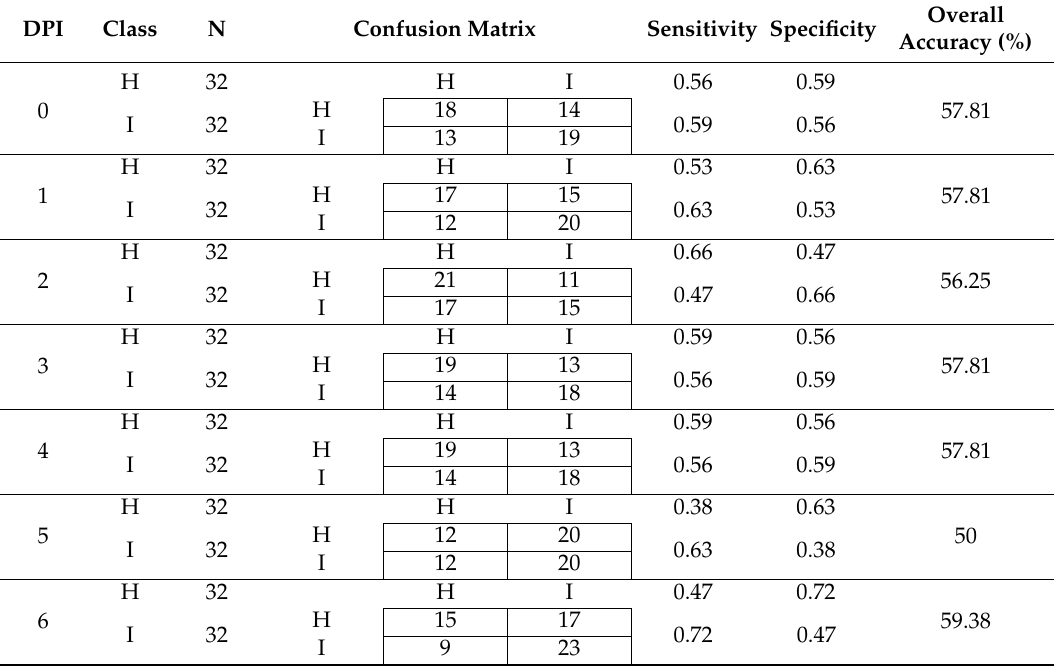
Table 4. Confusion matrix and related statistics when a linear Support Vector Machine (SVM) classifier is applied to the red-well point (RWP) wavelength to classify 32 healthy and 32 infected spectral observations acquired at canopy level as a function of the number of days post-inoculation